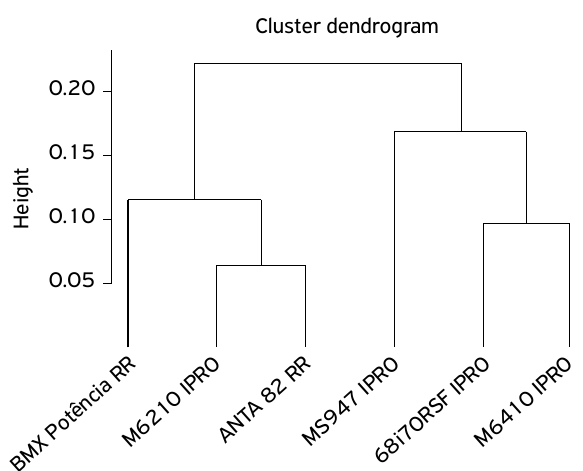
Figure 2. Average linkage clustering of soybean varieties based on the variables associated to infestation, survival, and development duration, and longevity of Bemisia